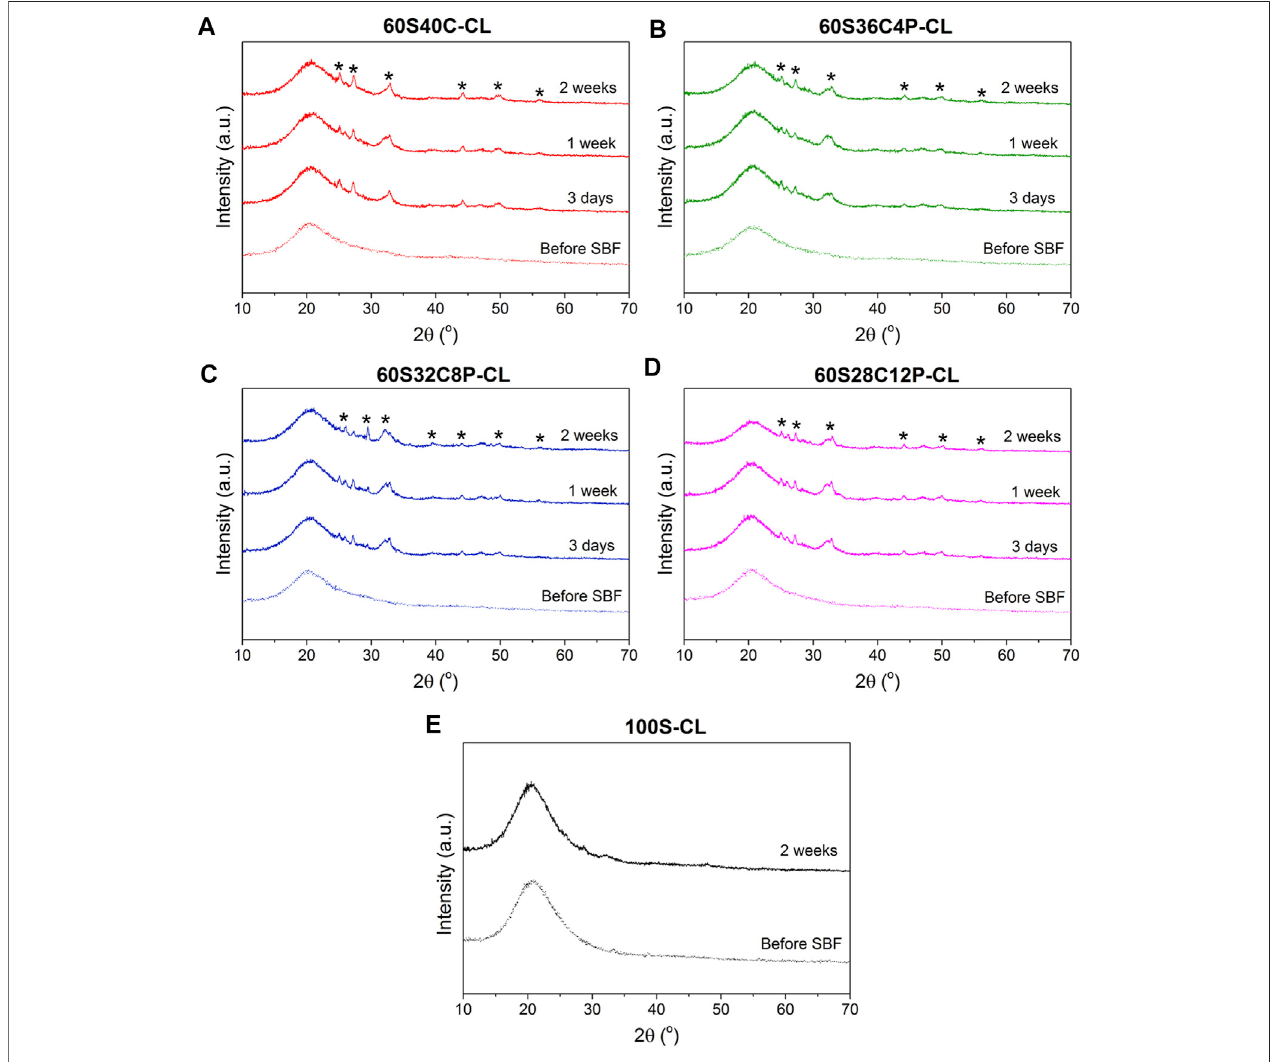
FIGURE 7 | (A – D) XRD patterns of the four Ca-containing hybrid compositions before and after soaking in SBF for 3-7-14 days: (A) 60S40C-CL, (B) 60S36C4P- CL, (C) 60S32C8P-CL, (D) 60S28C12P-CL; (E) XRD patterns of the reference Ca-free hybrid before and after 14 days in SBF. * notates peaks matching ICDD